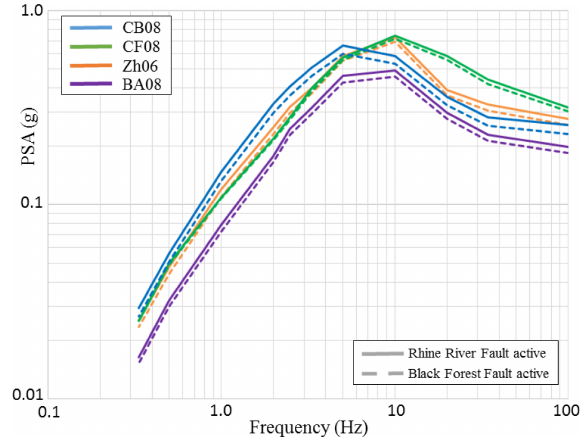
Figure 6. UHS at a 10000-year return period considering four GM- PEs: CB08, CF08, ZH06 and BA08 (see Table 3 for references). Seismogenic depth of 15km, the steepest dip of faults, the slowest slip rate, a Gutenberg–Richter frequency-magnitude